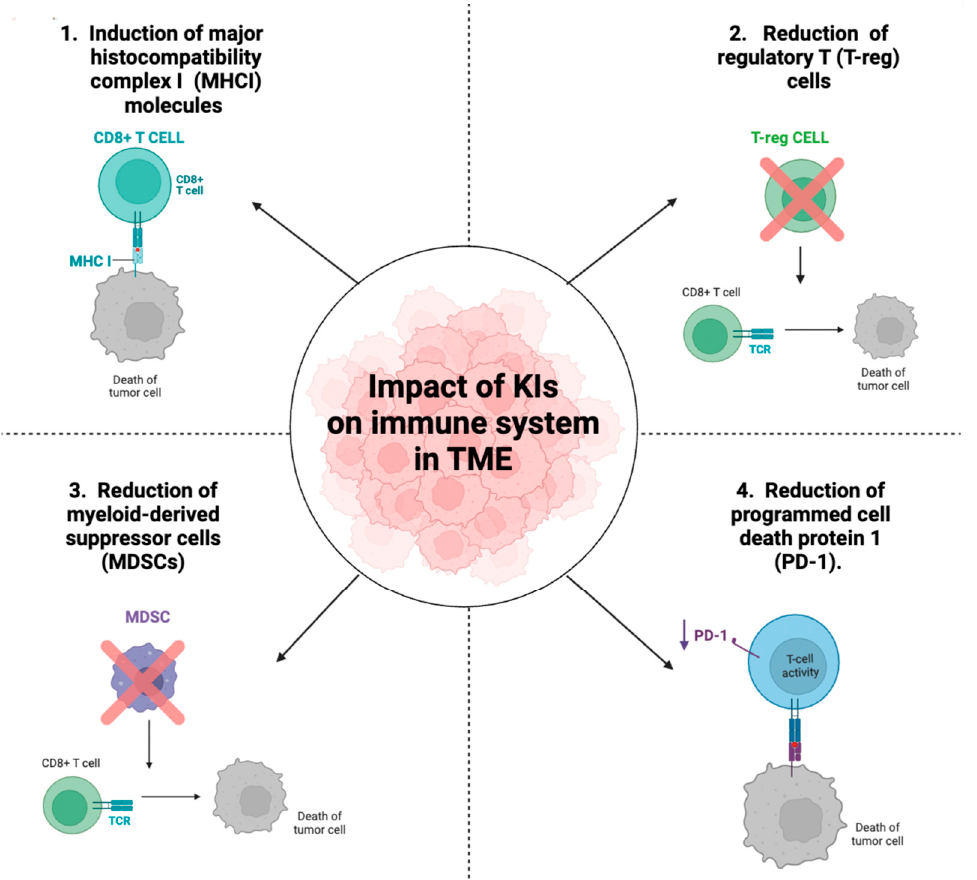
Figure 3. Impact of KIs on immune cells in TME. Some KIs through intrinsic mechanisms linked to the blocking of protein kinases, in addition to reducing the growth of cancer cells, can induce anti-tumor immunity. Some KIs mediated anti-tumor immunity through several mechanisms. These include: induction of MCHI molecules which increases the cytotoxic activity of CD8+ T-cells (panel 1), reduction of T-reg (panel 2), and MDSC cells (panel 3), causing an increase in immune cells and a reduction of PD1 expression on lymphocytes, which increases their cytotoxic activity (panel 4). The figure was created with the help of Biorender.com (accessed on 6 September